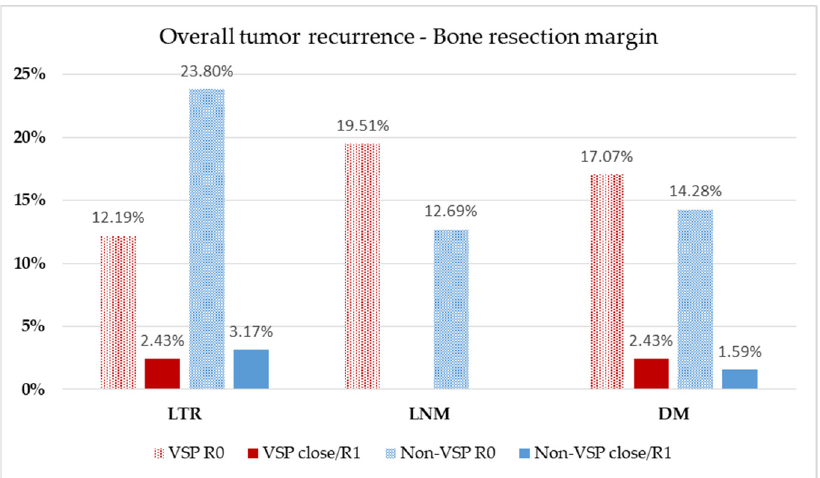
Figure 5. Evaluation of bony resection margin. Relative distribution of local tumor recurrence (LTR), lymph node metastasis (LNM), and distant metastasis (DM) according to the method of reconstruction planning. Patients at risk: VSP group, n = 41 (follow-up, 20.5 ± 16.4 months); non-VSP group, n = 63 (follow-up, 64.9 ± 52.1 months).